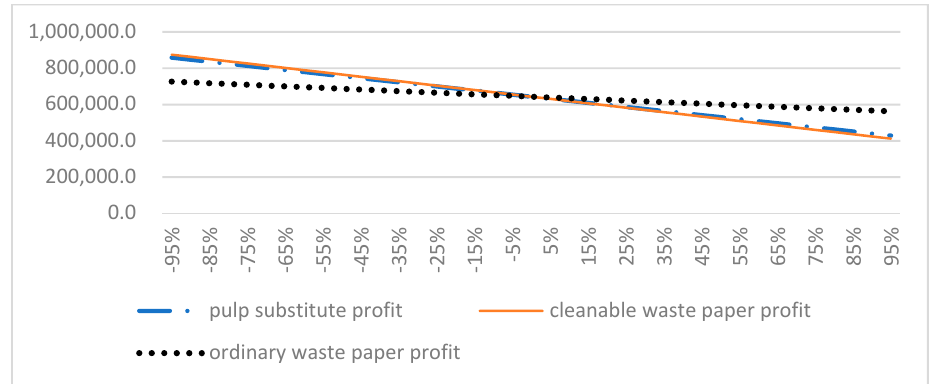
Figure 5. The impacts of cost decrease and capacity increase on profit (unit: thousand dollars).